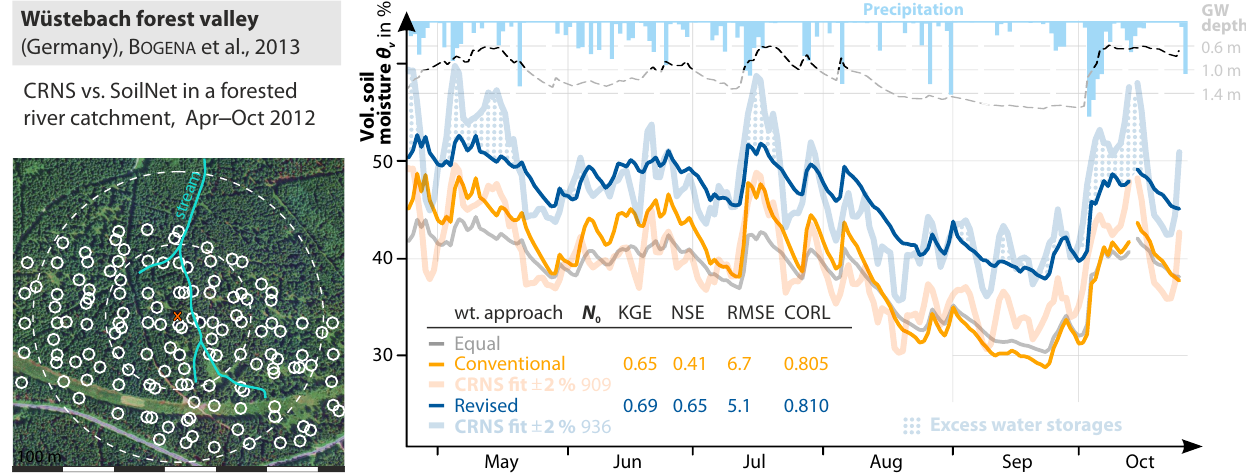
Figure 9. Time series of CRNS soil moisture and groundwater at the Wüstebach forested river catchment. Fitting the CRNS data to the SoilNet conventional average almost completely hides effects from excess water storages (which could include water in the litter layer, interception water, groundwater rise, or ponding close to the stream). The revised approach emphasizes those additional hydrological processes while still robustly increasing the sensor